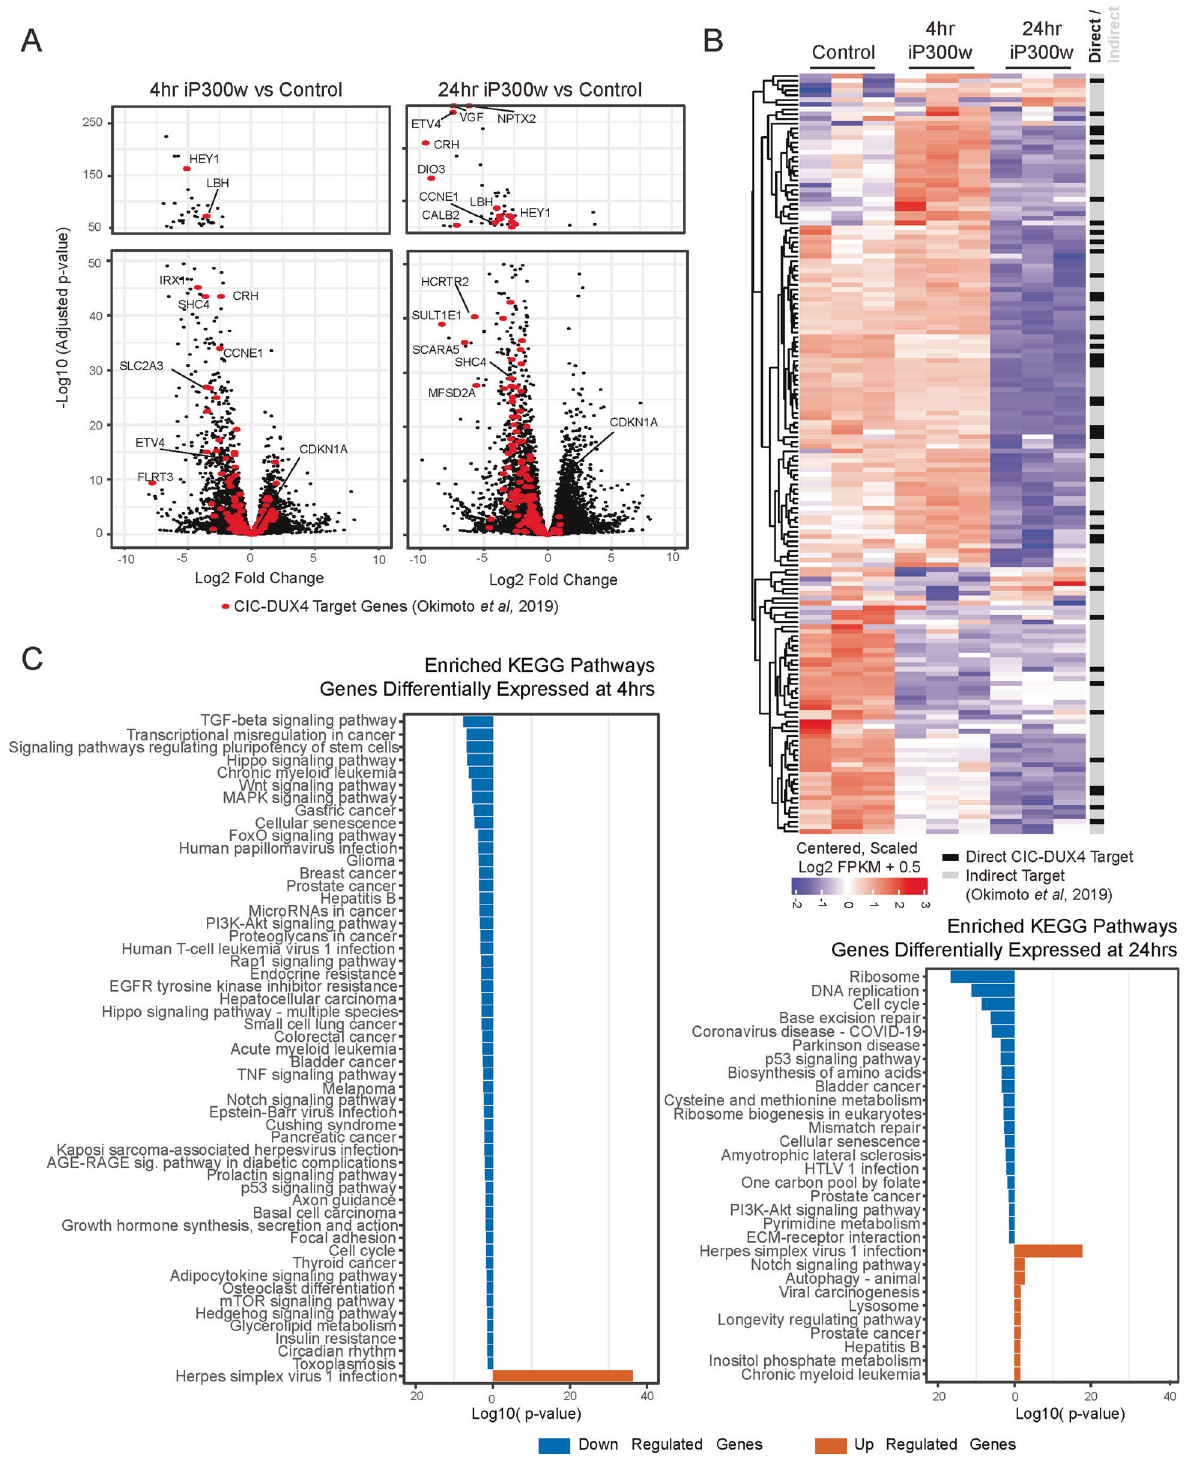
Fig. 5 iP300w suppresses the CIC-DUX4 target transcriptome. A Scatter plots of − log10 fold change of the Benjamini – Hochberg adjusted p - value versus the observed log2 fold change in gene expression. The changes with 4 and 24 h of iP300w treatment are shown on the left and right, respectively. The y -axis in each plot has been expanded in the lower panels relative to the upper panels. Points colored in red correspond to the 165 transcripts upregulated by CIC-DUX4 as previously reported [16]. B Heatmap of the log2 padded FPKM values of CIC- DUX4 targets from Okimoto et al. [16] in NCC-CDS1-X1 cells upon treatment with iP300w. C Enriched KEGG pathways (hypergeometric test, Benjamini – Hochberg adjusted p -value < 0.05) of the differentially expressed genes at 4 h (left) and 24 h (lower right). The x -axis corresponds to the log10 adjusted p -value such that downregulated genes are shown on the negative axis (blue) and upregulated genes (orange) are shown on the positive axis in each